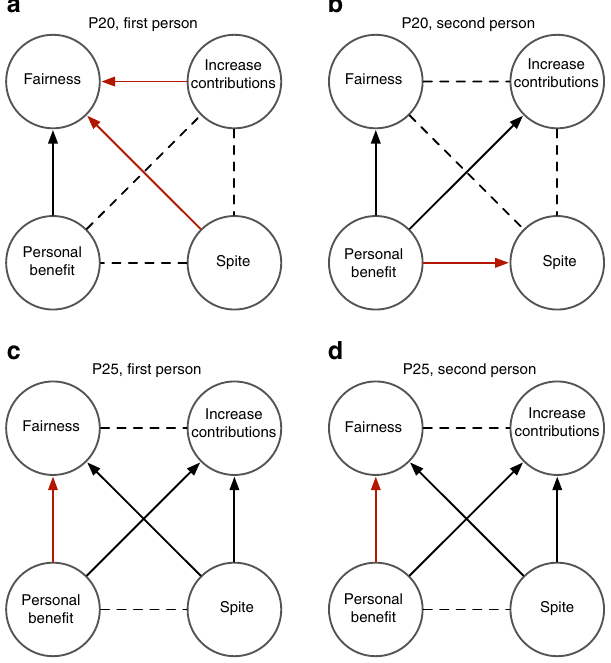
Fig. 2 Relative frequency of reasons cited to explain punishment.